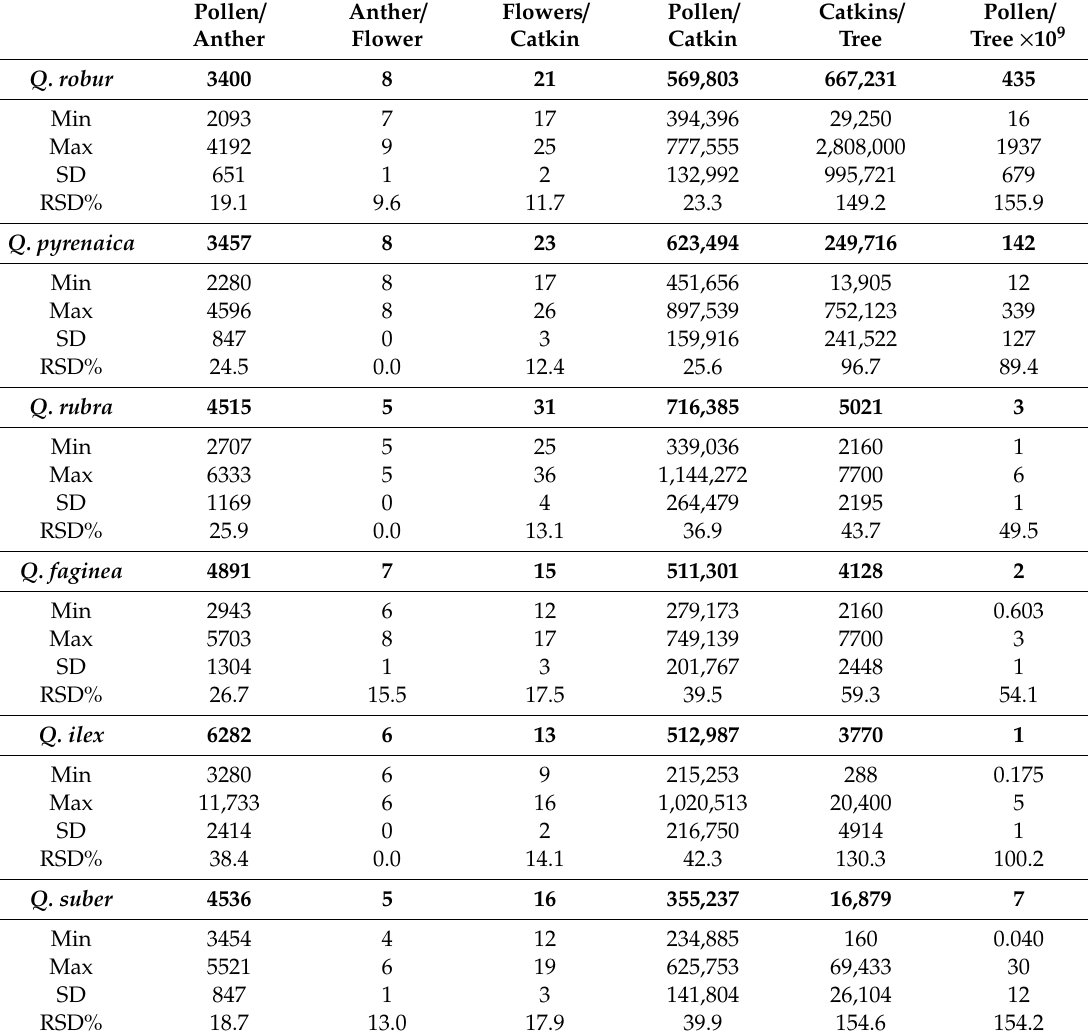
Table 1. Average, minimum (Min), and maximum (Max) values, standard deviation (S.D.) and the relative standard variation in percentage (%RSD) of the pollen per anther, anthers per flower, flowers per catkin, pollen per catkin, catkins per tree and pollen per tree of the studied Quercus